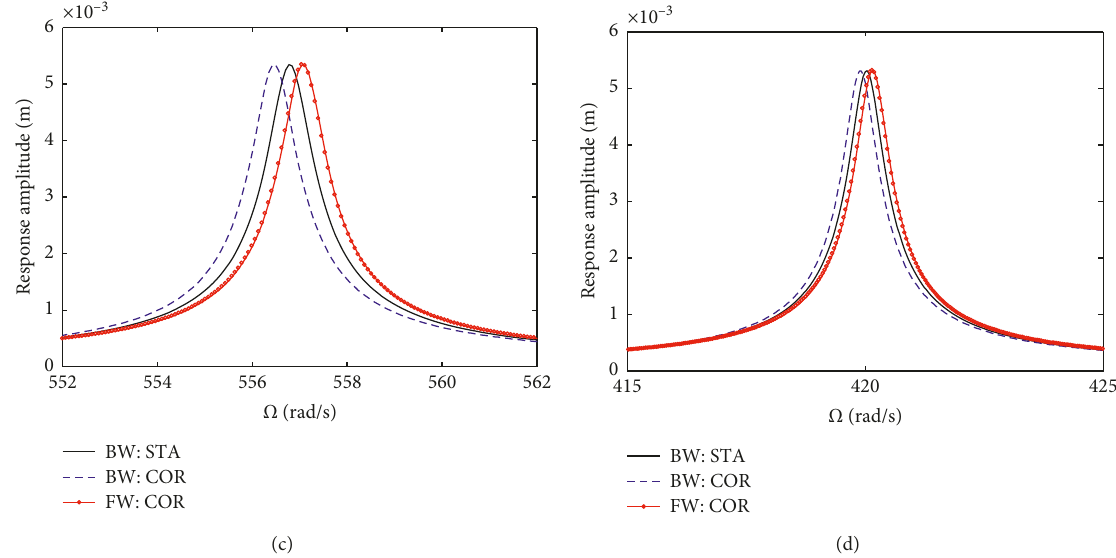
Figure 7: Forced response of tuned bladed disk with and without considering the Coriolis forces excited by backward and forward traveling wave excitations of (a) 2EO, (b) 2EO, (c) 3EO, and (d) 4EO.